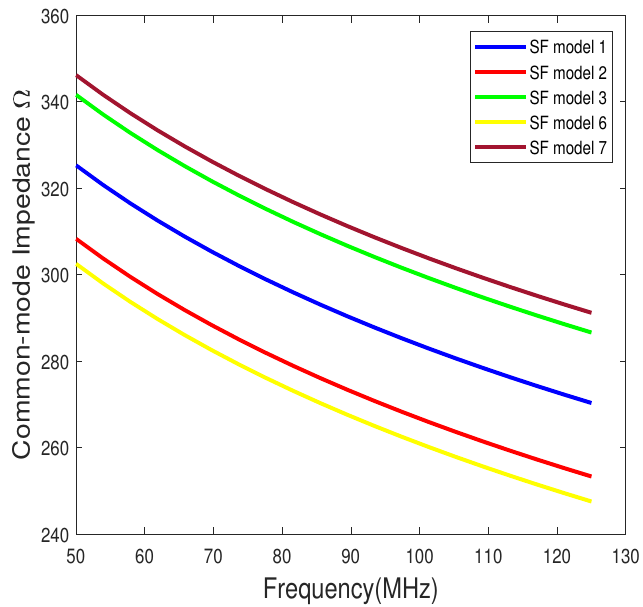
Figure 14. Common mode characteristic impedance of single-fold (SF) antenna models with respect to frequency. SF models 4 and 5 will show similar characteristic impedance as SF model 1.